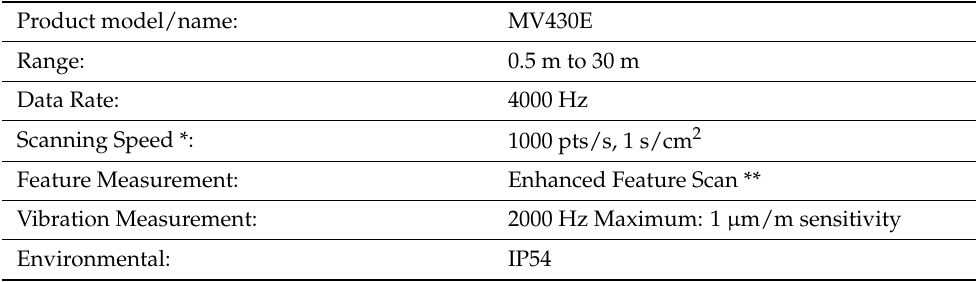
Table 2. APDIS laser radar MV430E working limit and accuracy performance measures.